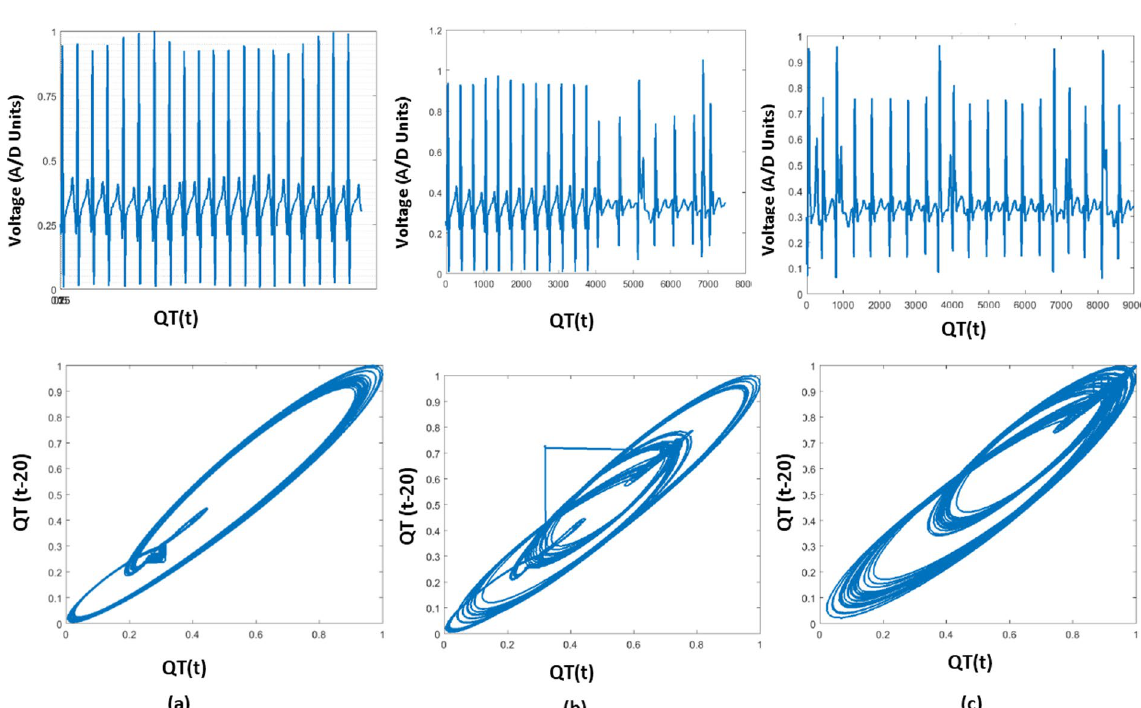
Figure 16. PSR plots of the window occupying QT, (case a ) Window having only Healthy QT intervals and its PSR plot, (case b ) Window having a combination of healthy and unhealthy QT intervals and its PSR plot, (case c ) Window having only unhealthy QT intervals and its PSR